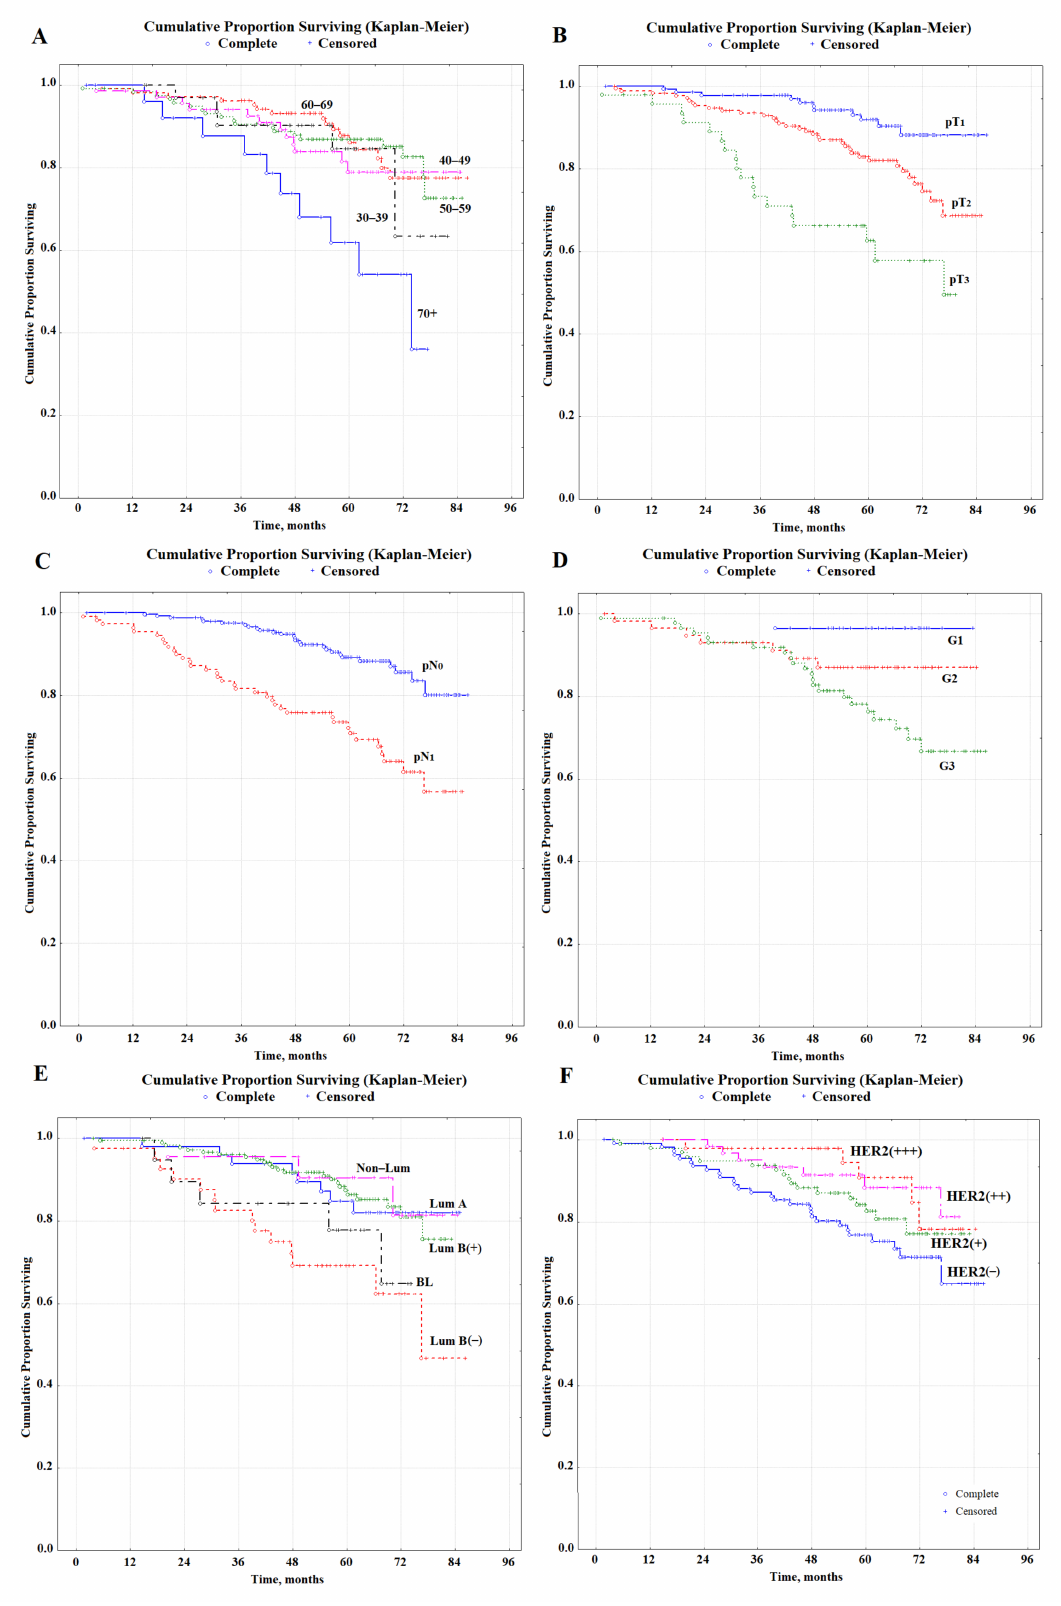
Figure 1. Overall survival of patients with primary resectable breast cancer depending on age ( A ), tumor size ( B ), lymph node disease status ( C ), tumor differentiation ( D ), molecular biological sub- type ( E ), and HER2 status ( F